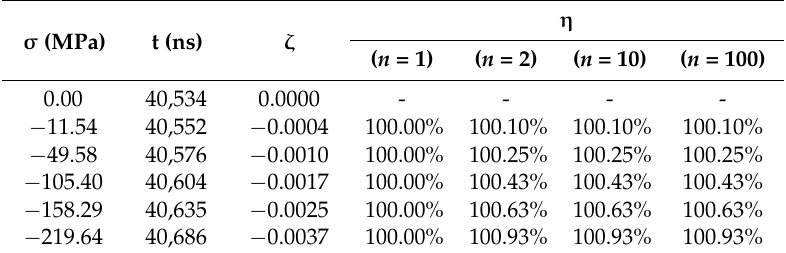
Table 1. The contribution percentage of the first item in Equation (8) under different